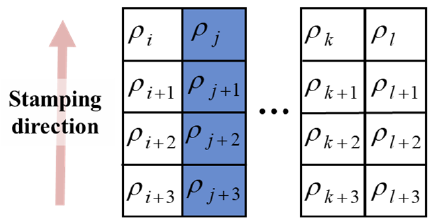
Figure 6. Schematic Diagram of Stamping Constraint.